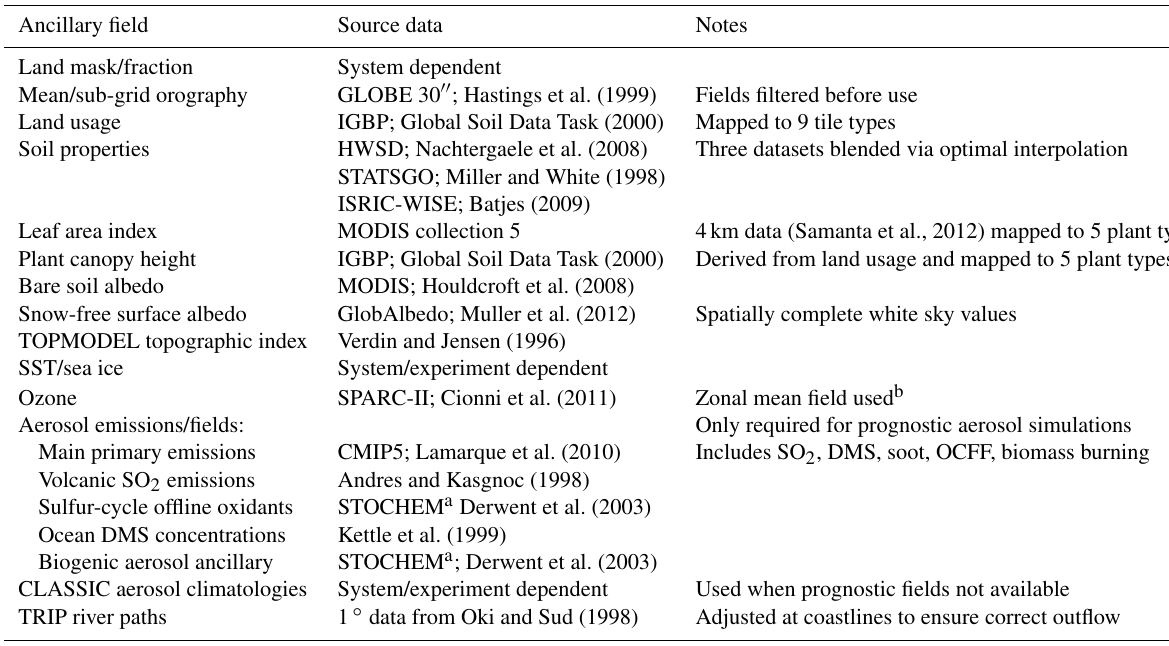
Table 1. Source datasets used to create standard ancillary files used in